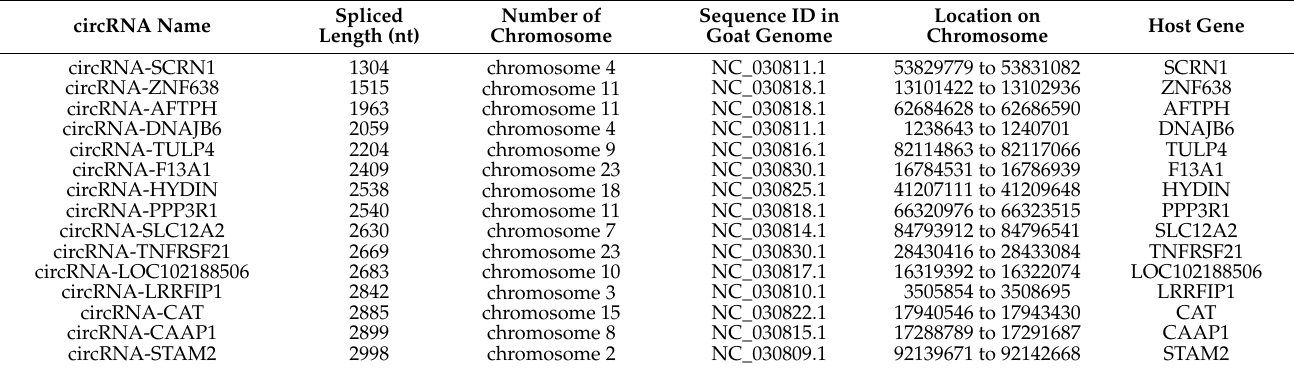
Table 2. Genomic location information of the 15 analyzed m 6 A-circRNAs with their host genes a